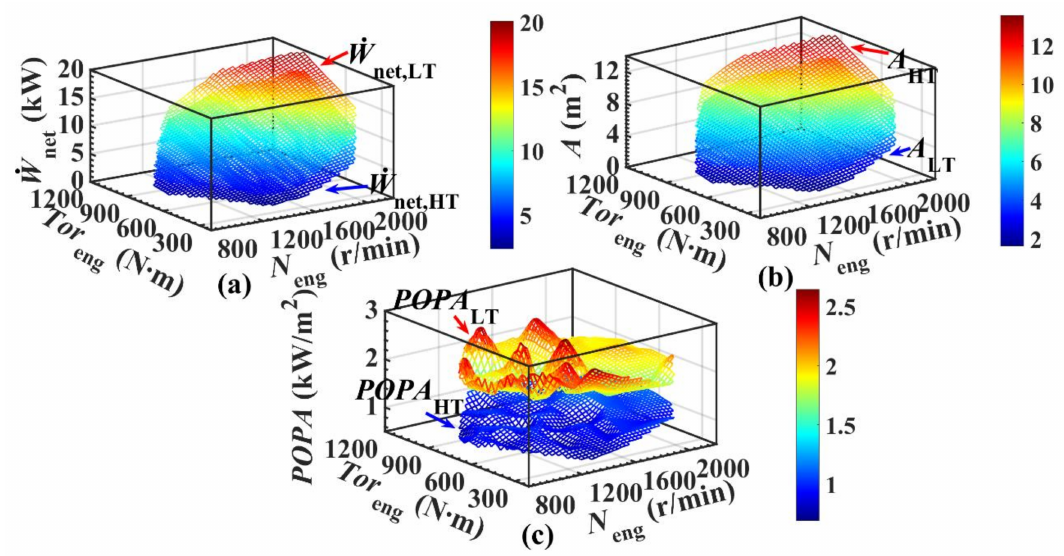
Figure 10. Dynamic response characteristics of HT loop and LT loop POPA under full operating conditions. ( a ) dynamic response characteristics of net power output of HT and LT loop. ( b ) dynamic response characteristics of the heat transfer area of the HT and LT loop. ( c ) dynamic response characteristics of POPA of the HT and LT